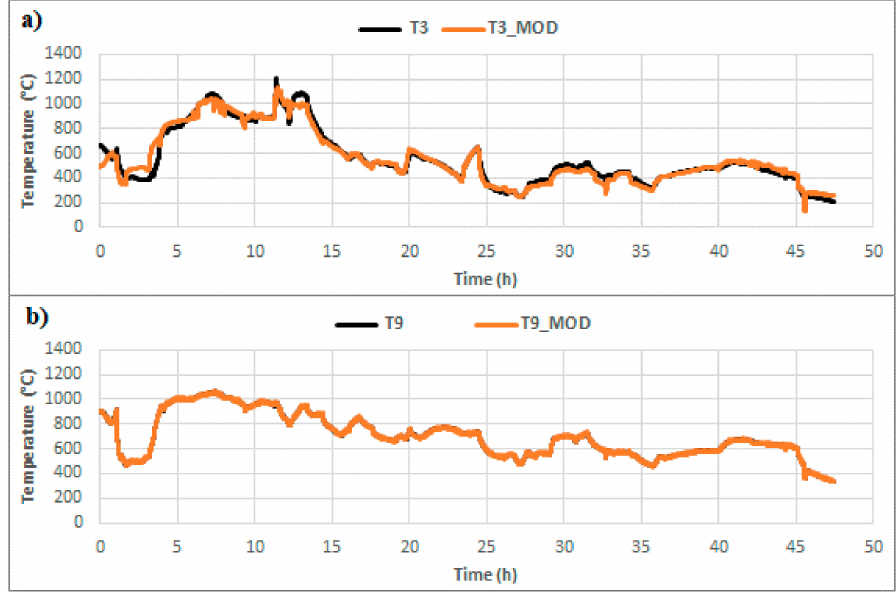
Figure 10. The measured (T) and modelled (T_MOD) temperature behavior, ( a ) temperature T 3 , ( b ) temperature T 9 (Source: own